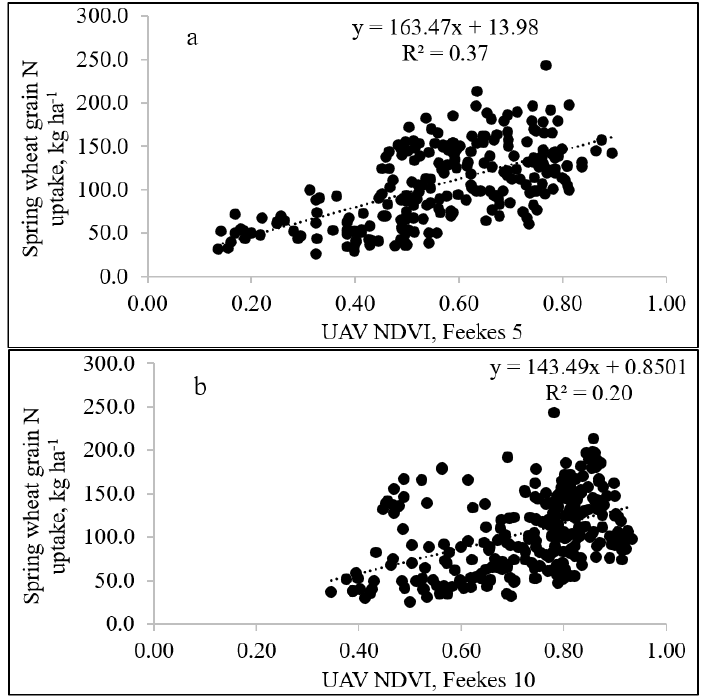
Figure 6. Relationship between Normalized Difference Vegetative Index (NDVI) at Feekes 5 ( a ) and Feekes 10 ( b ) growth stages collected using the Unmanned Aerial Vehicle (UAV) 3D Robotics 8X+ octocopter equipped with MicaSense Red Edge ™ 3 Multispectral Camera and spring wheat grain N uptake (kg ha −1 ) for 14 site-years in Idaho, 2015 – 2017.